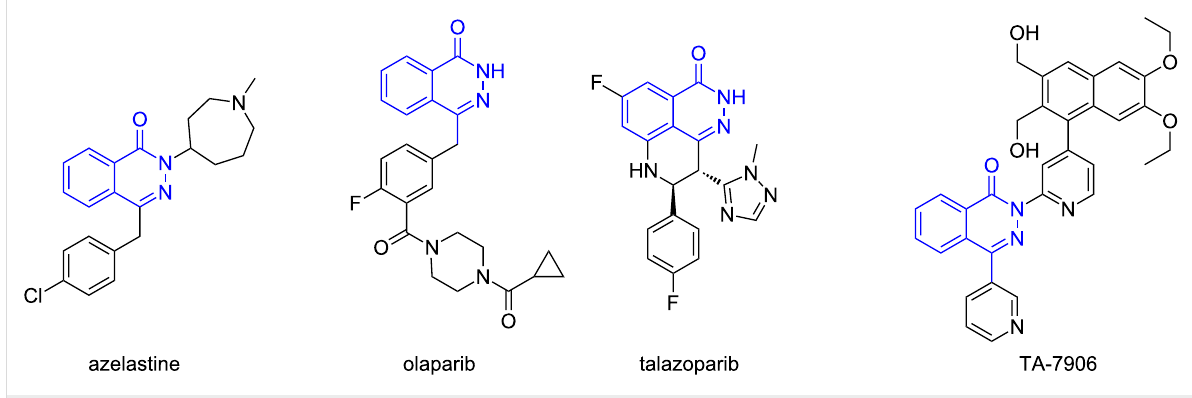
Figure 1: Representative structures of biologically important phthalazin-1(2 H )-ones.